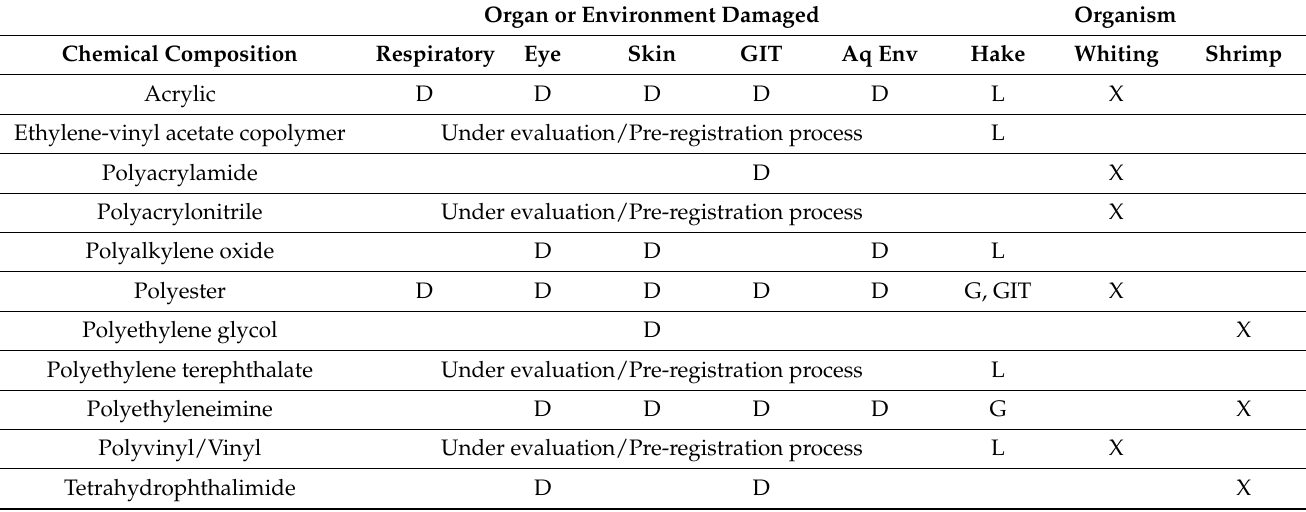
Table 2. Polymer types identified by µ -FT-IR from items found in water, hake tissues and hake preys that might encompass risks. Presence in a sample is marked with X. Substances labelled by the European Chemical Agency as dangerous for health, are marked with the letter D. GIT, gastrointestinal tract; Aq Env: specific risk for aquatic environments. Presence in hake tissues: L-liver, G-gills, GIT-gastrointestinal